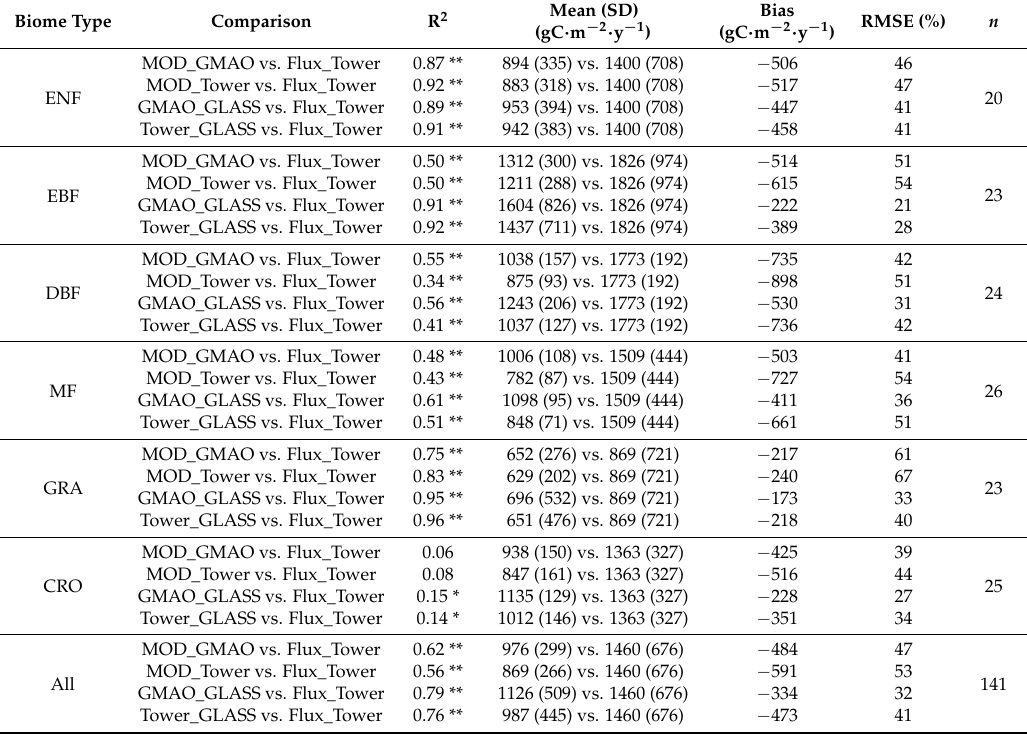
Table 3. Biome-based comparison of the annual GPP derived from the site estimates with those derived from the MODIS algorithms (MOD_GMAO GPP, MOD_Tower GPP, GMAO_GLASS GPP and Tower_GLASS GPP).ENF: evergreen needleleaf forests; EBF: evergreen broadleaf forests; DBF: deciduous broadleaf forests; MF: mixed forests; GRA: grasslands; CRO: